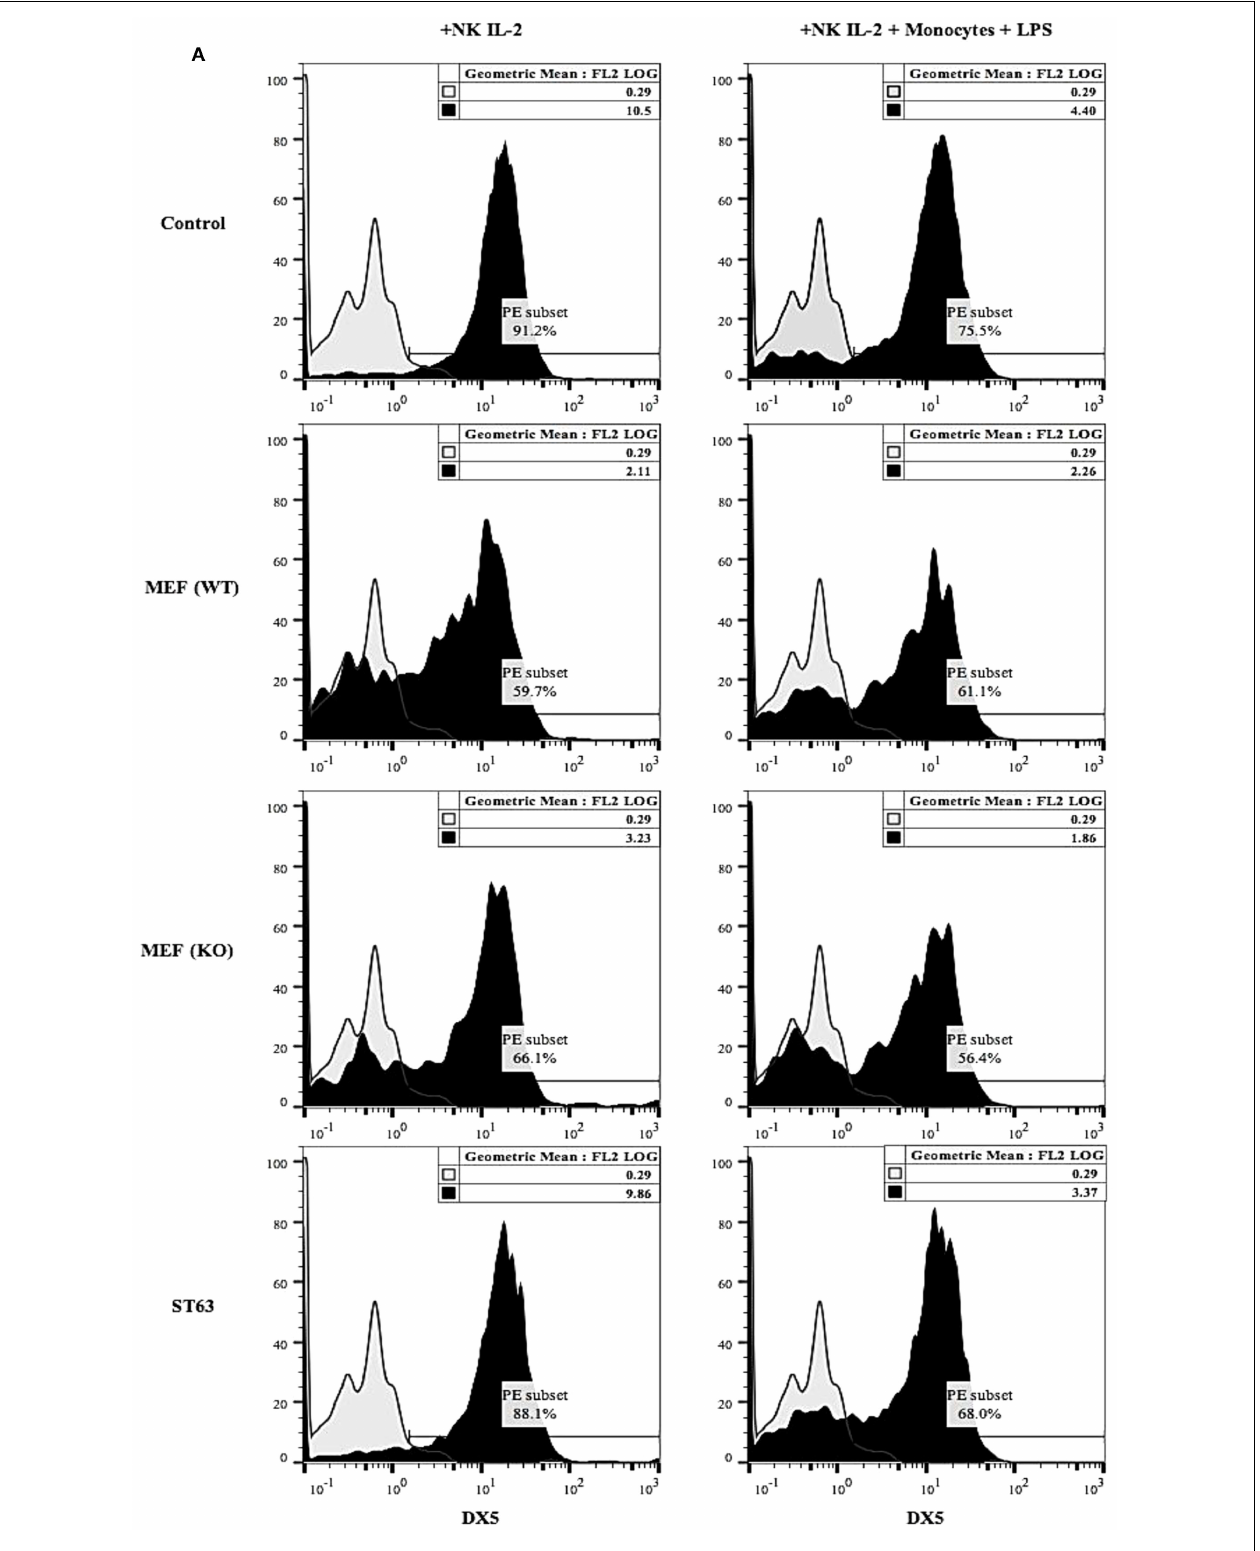
FIGURE 6 | Receptor analysis of purified splenic NK cells co-cultured with MEFs from wild type and COX-2 knockout mice